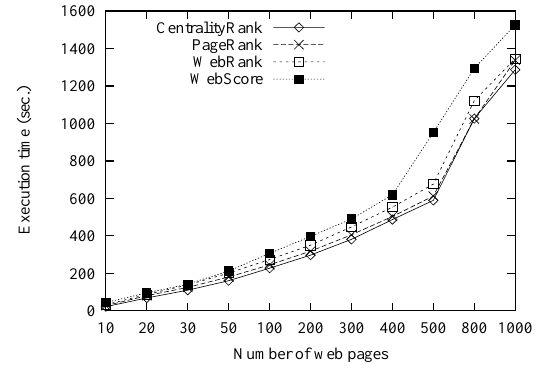
Fig. 5. Execution time comparison among algorithms.